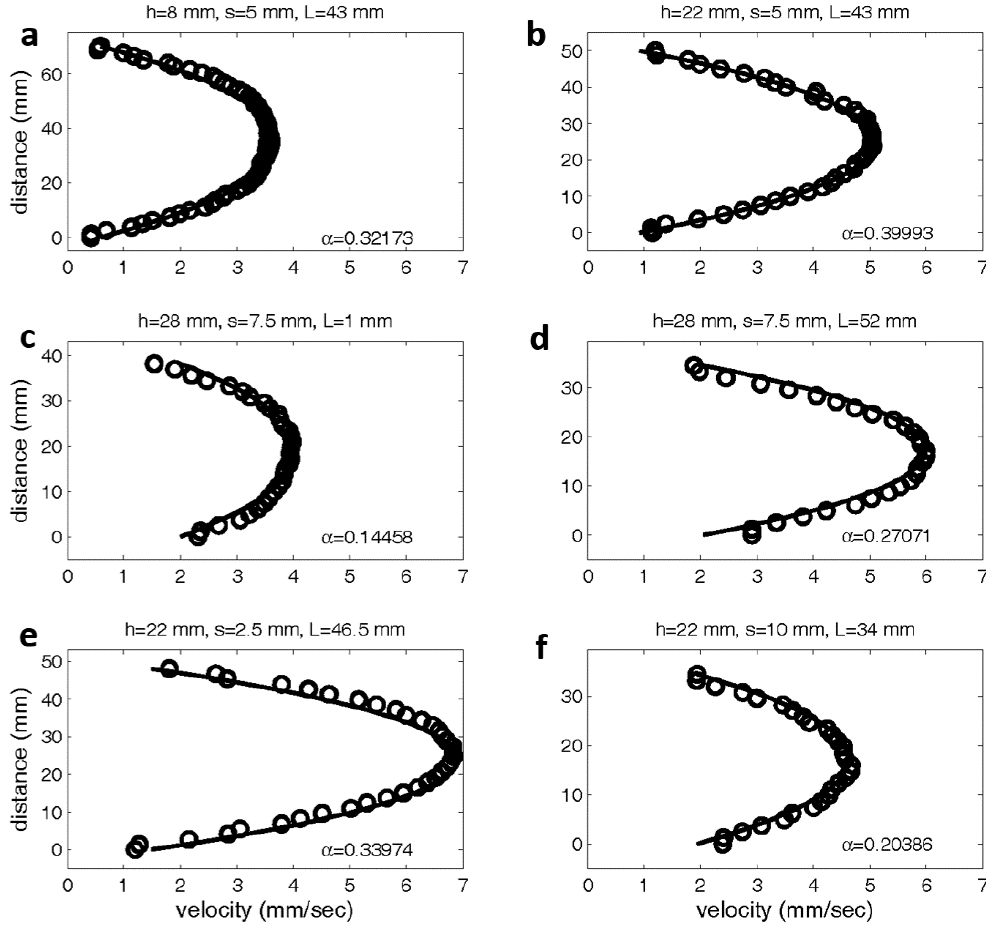
Figure 5. Experimentally and theoretically determined velocity profiles between two model layers. The experimental data is labeled with open circles, and the theoretical predictions are denoted with a solid line. The values of α have units of cm − 1 . In the top row, the spacing between pins and layer length is fixed at 5 mm and 43 mm, respectively. The height is varied from 8 mm ( a ) to 22 mm ( b ). The middle rows shows the velocity profiles are shown between two layers with a constant height of 28 mm and spacing of 7.5 mm. The length of the layer was varied from 1 mm ( c ) to 52 mm ( d ). The bottom row shows profiles for a constant layer height of 22 mm and lengths of 46.5 and 34 mm. The spacing was varied from 2.5 mm ( e ) to 10 mm ( f